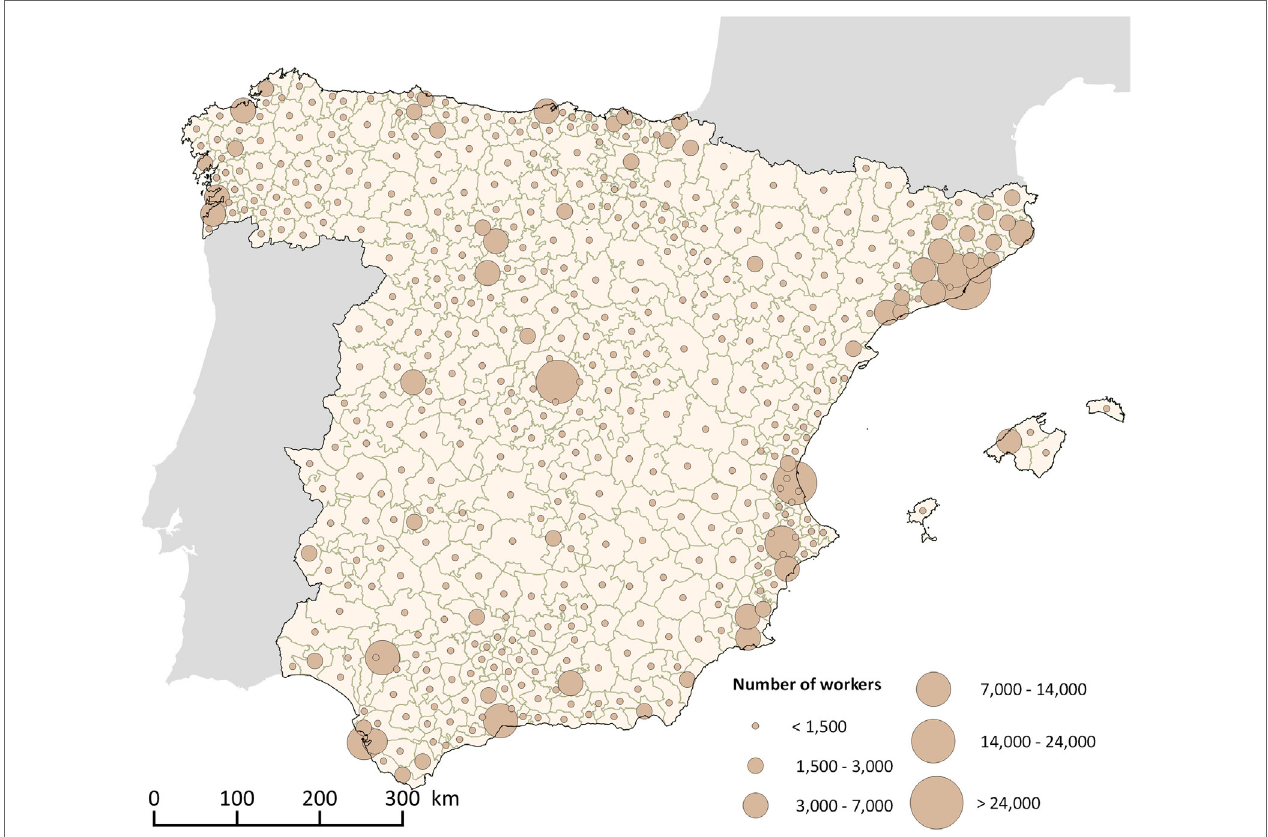
FigUre 6 | Total number of industrial workers in Spain in 1860 by judicial party. This figure does not include artisans. Source: Own